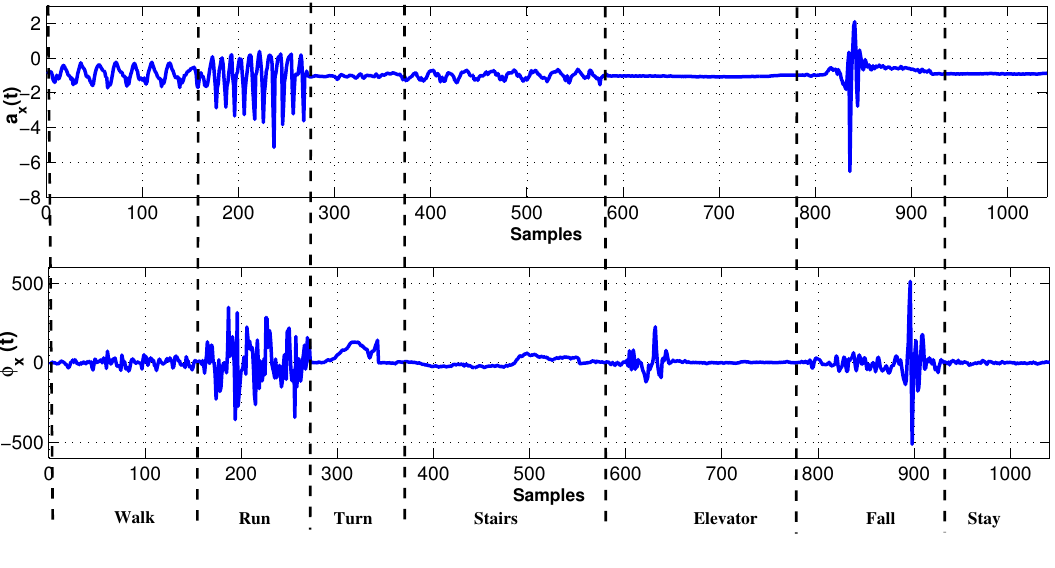
) and tilt angle ( φ ) signals of human motions obtained from x x